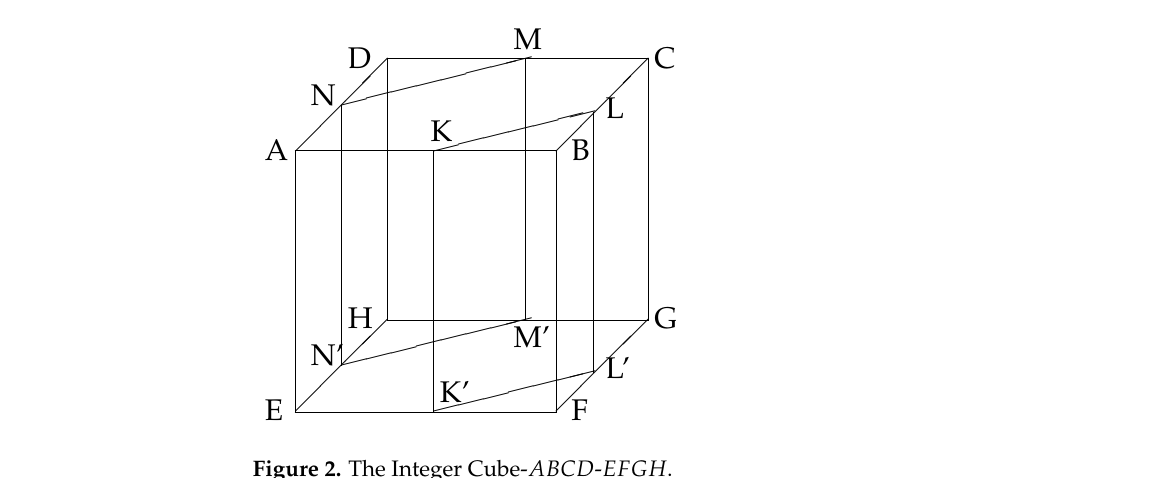
Figure 2. The Integer Cube- ABCD - EFGH . A pandiagonal plane of a pandiagonal magic cube is also a pandiagonal magic square. In fact, let us begin with a pandiagonal Latin cube. Let ABCD - EFGH be a pandiagonal Latin cube, then its each pandiagonal plane has the same generating transformation with the diagonal plane parallel to itself. For example, the diagonal plane ACGE of T 3,5 ( 1, 2, · · · , 11 ) of Section 3 is given by